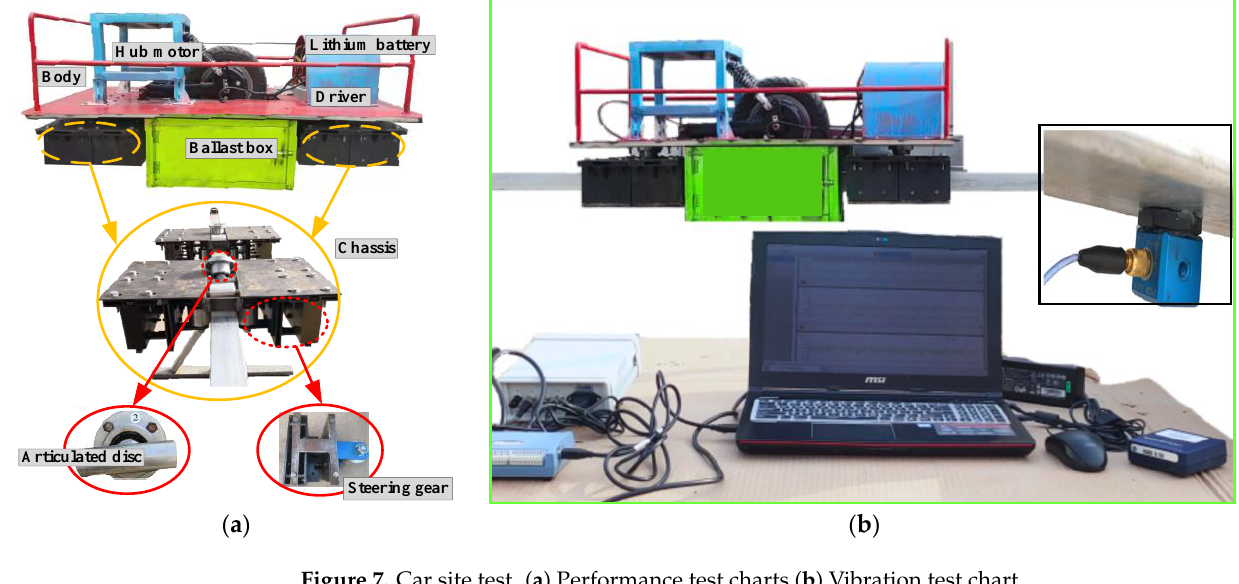
Figure 7. Car site test . ( a ) Performance test charts ( b ) Vibration test chart .